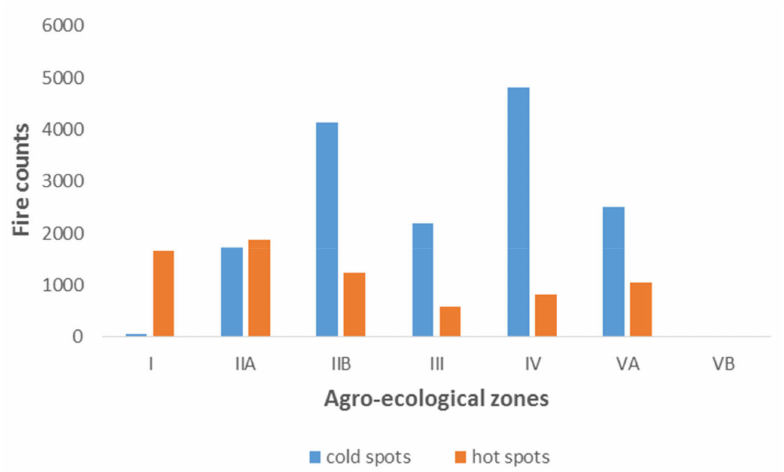
Figure 4. Fire intensity clusters in agroecological zones.